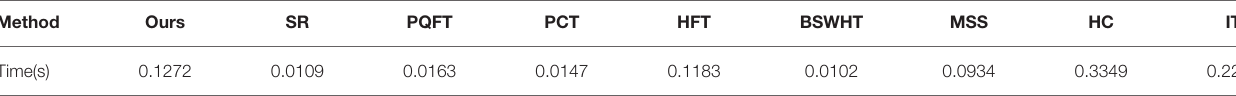
TABLE 3 | Computational time cost per image for all saliency methods over the ECSSD dataset.